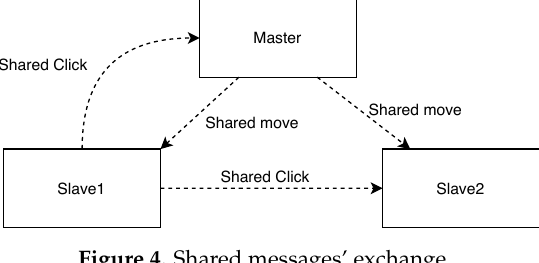
Figure 4. Shared messages’ exchange.